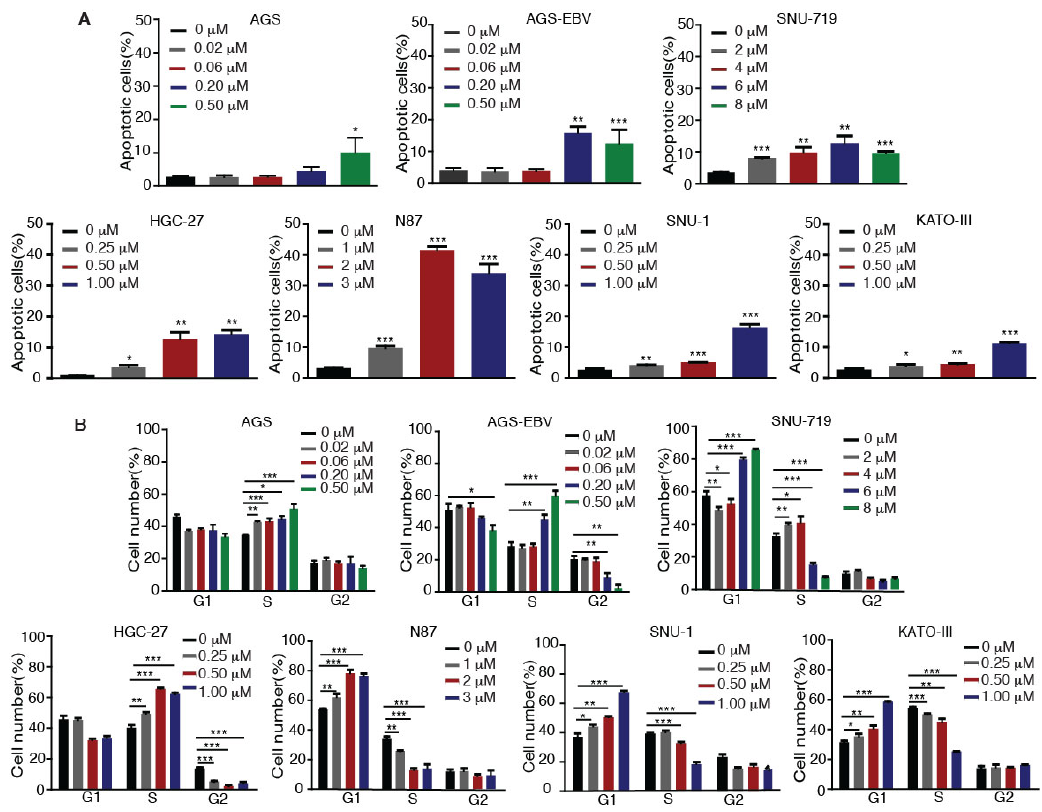
Figure 2. Tenovin-6 induces apoptosis and cell-cycle arrest of GC cells. ( A ) Percentages of apoptotic cells in the indicated cell lines after Tenovin-6 treatment based on annexin V and propidium iodide (PI) staining. * p < 0.05, ** p < 0.01, *** p < 0.001. ( B ) Percentages of cells at gap 1 (G1), synthesis (S), and G2 / mitotic (M) phases of the indicated cell lines after Tenovin-6 treatment based on PI staining. * p < 0.05, ** p < 0.01, *** p <